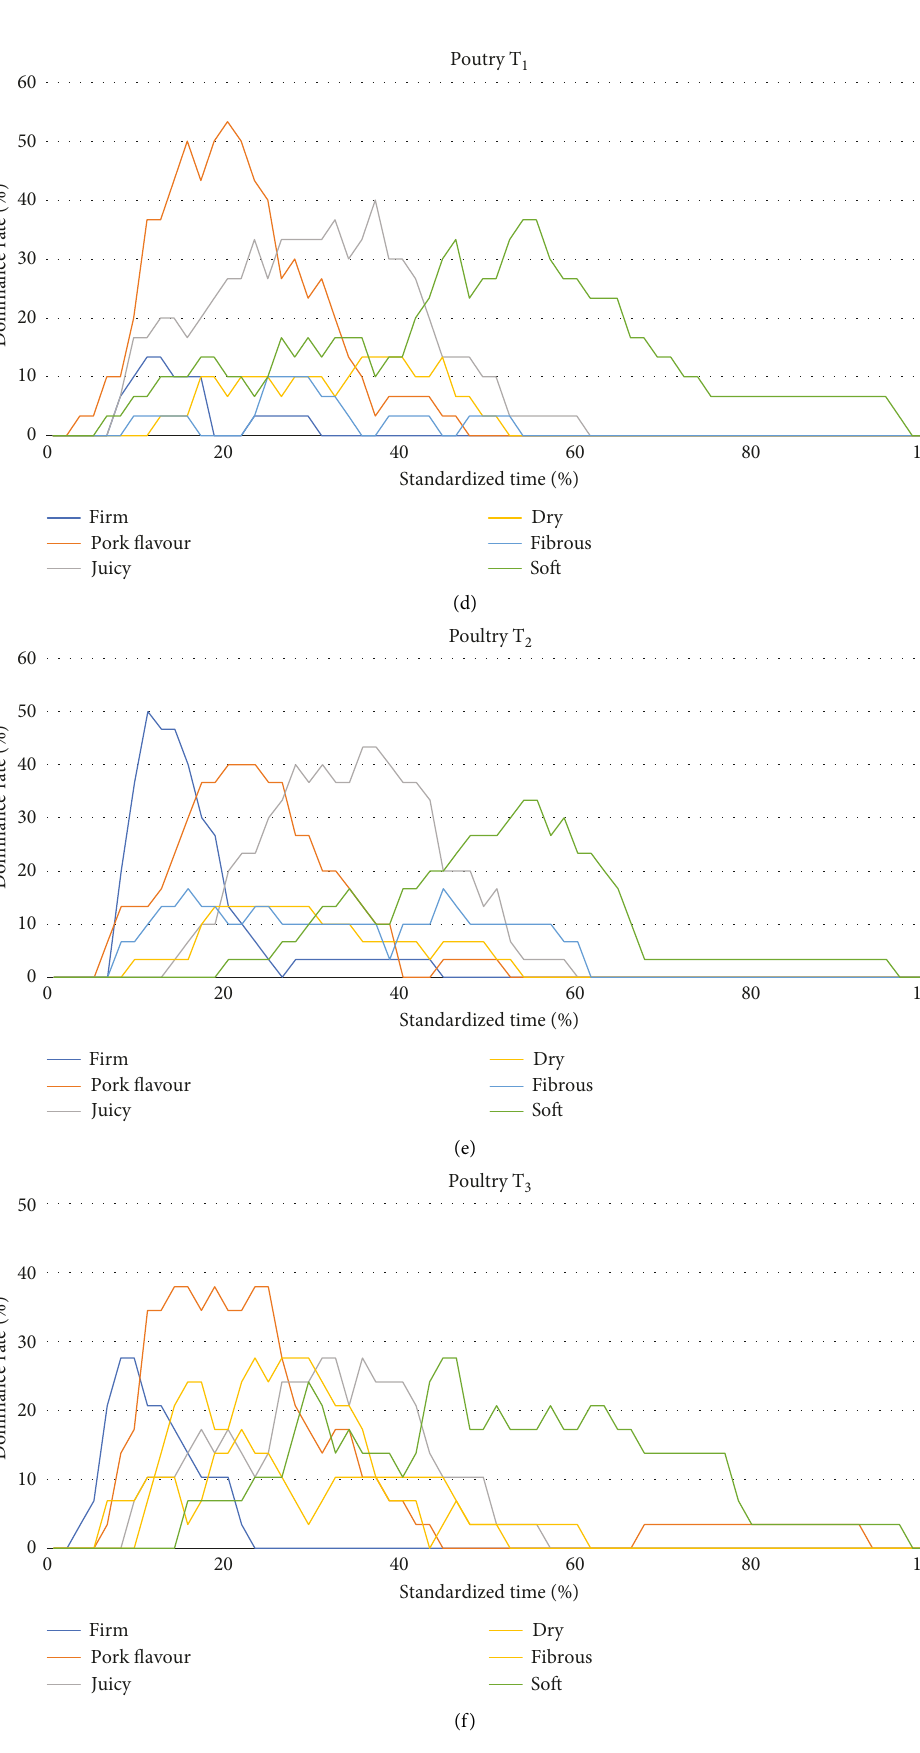
Figure 2: Temporal dominance sensation (TDS) curves for pork meat (a-c) and poultry meat (d-f) for three grilling temperatures methods. Defined time axis from t � 0 (first bite—0%) to t � 1 (swallowing—100%). Attributes are shown in different